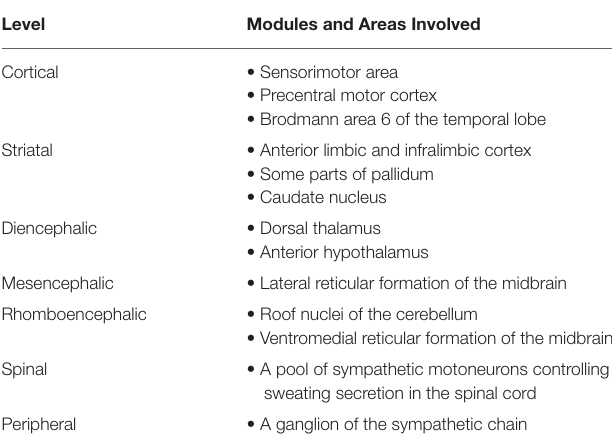
TABLE 1 | Level and its corresponding module(s) and involved area(s) .